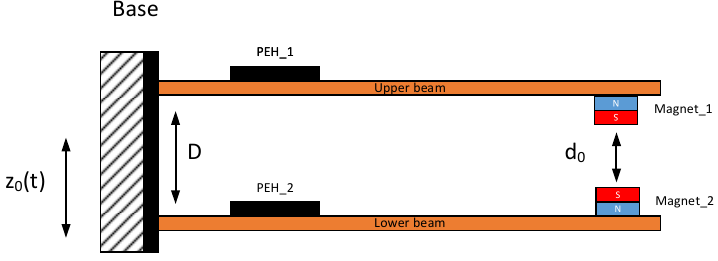
Figure 1. Schematic diagram of the magnetic coupled piezoelectric energy harvester.